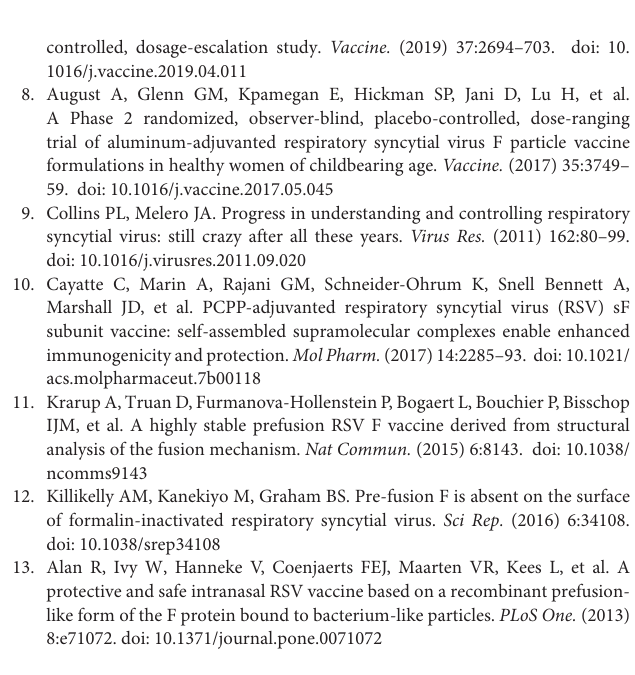
TABLE S1 | Hierarchically clustered heat maps. TABLE S2 | Immune-related Hierarchically clustered heat maps. TABLE S3 | VENN DOWN-regulated genes. TABLE S4 | VENN UP-regulated genes. DATA SHEET S1 | Supplementary material for RSV-F protein